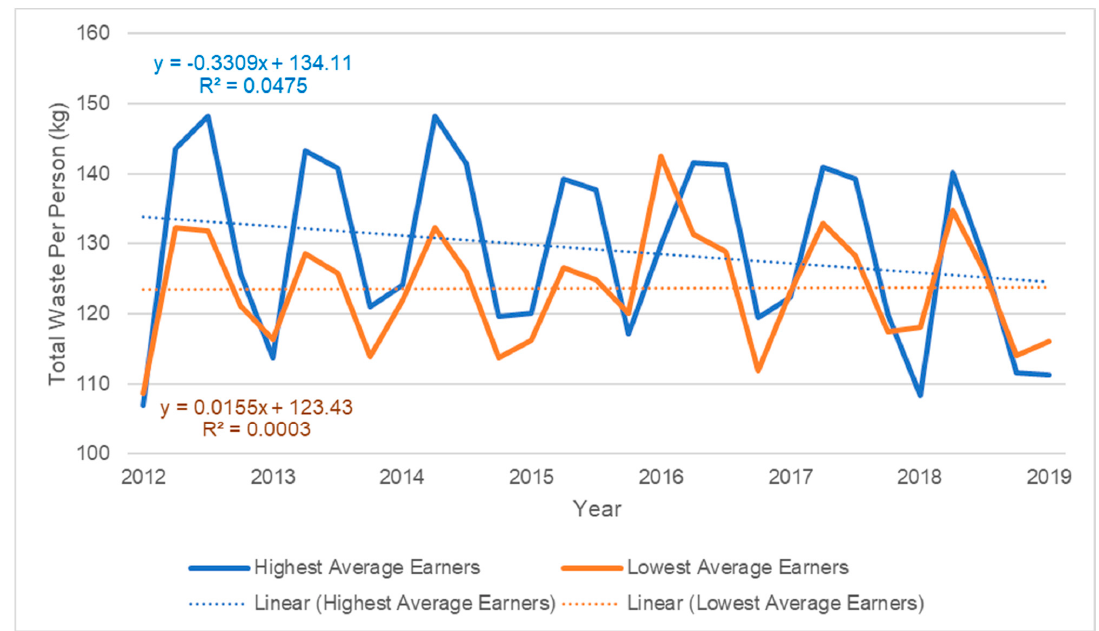
Figure 10. Total waste per person for the averaged highest and lowest earning local authorities in Wales. Source: WasteDataFlow and StatsWales. Dotted lines shows trend lines (by colour) represented also in figure by regression equations and coefficients of determination (R 2 ).